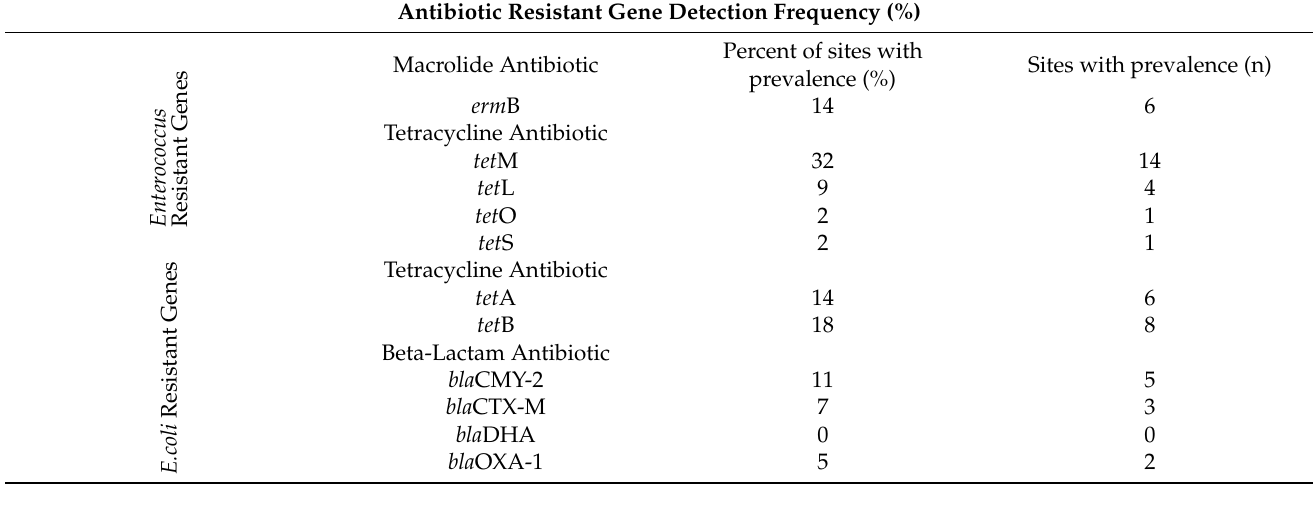
Table 4. Detection frequency of ARGs associated with resistance phenotypes by prevalence at all sites ( n = 45) for Tampa Bay Metropolitan Area, FL sample sites.